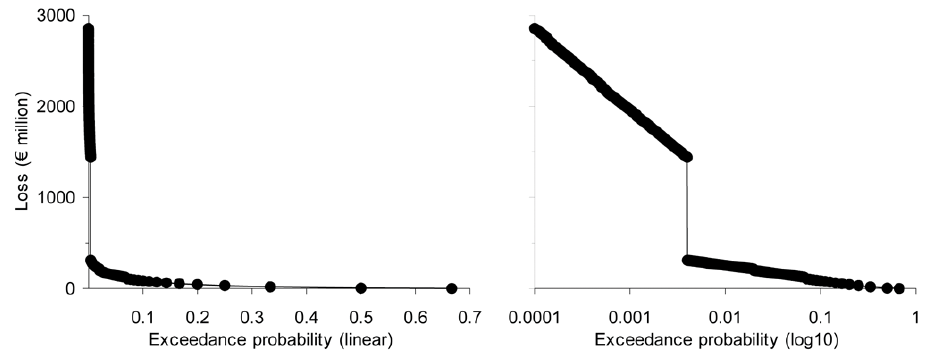
Fig. 7. Risk curve for flood losses with return-periods from 2 to 10000yr (in steps of 1), based on the official guideline HR2001. The curve is shown with exceedance probability on a linear scale (left) and logarithmic scale (right). The area under the curves is the expected annual damage, or risk; in this case ca. C 34million